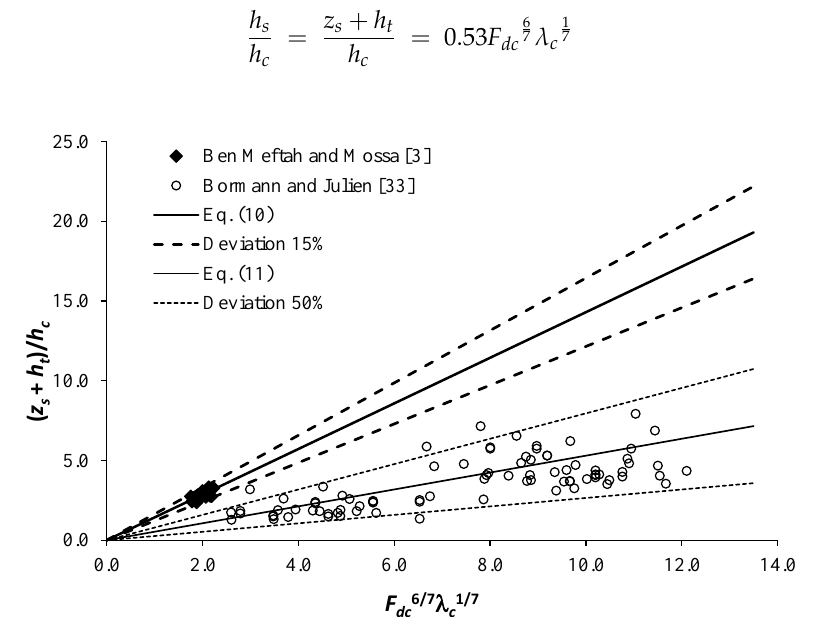
Figure 11. Validation of the scaling law of the maximum scour depth downstream of bed sills obtained by applying the fundamental laws of turbulent energy spectrum with σ = − 5/3, and thus F dc (4/(3 −σ ) λ c( − (1+ σ )/(3 −σ ) = F dc (6/7) λ c(1/7) . The data of Ben Meftah and Mossa [3] were obtained downstream of bed sills in alluvial channels and with a bed sediment size of d 50 = 1.8 mm.